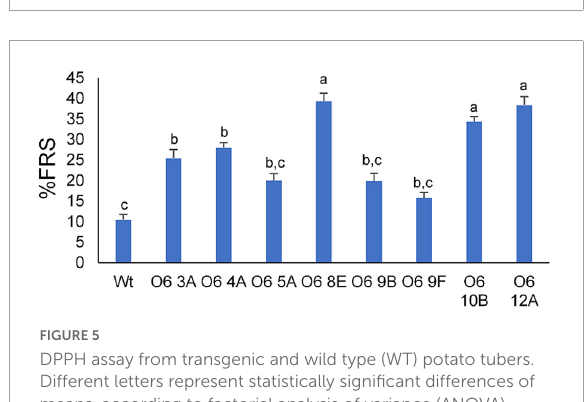
FIGURE4 Expression of endogenous carotenoid and apocarotenoid genes in transgenic and wild type (WT) potato tubers. DXS, 1-deoxy- D -xylulose-5-phosphate synthase; DXR, 1-deoxy- D -xylulose-5-phosphate reductase; PSY1, phytoene synthase 1; PSY2, phytoene synthase 2; PDS, phytoene desaturase; LCY-b, lycopene β -cyclase; LCY-e, lycopene ∈ -cyclase; BCH, β -carotene hydroxylase; CCD1, carotenoid cleavage dioxygenase 1; CCD4, carotenoid cleavage dioxygenase 4. qRT-PCR was performed in triplicate with three biological repeats. Error bars represent SD. *,**Significant differences from WT at P < 0.05 and P < 0.01, respectively, by Student’s t -test.